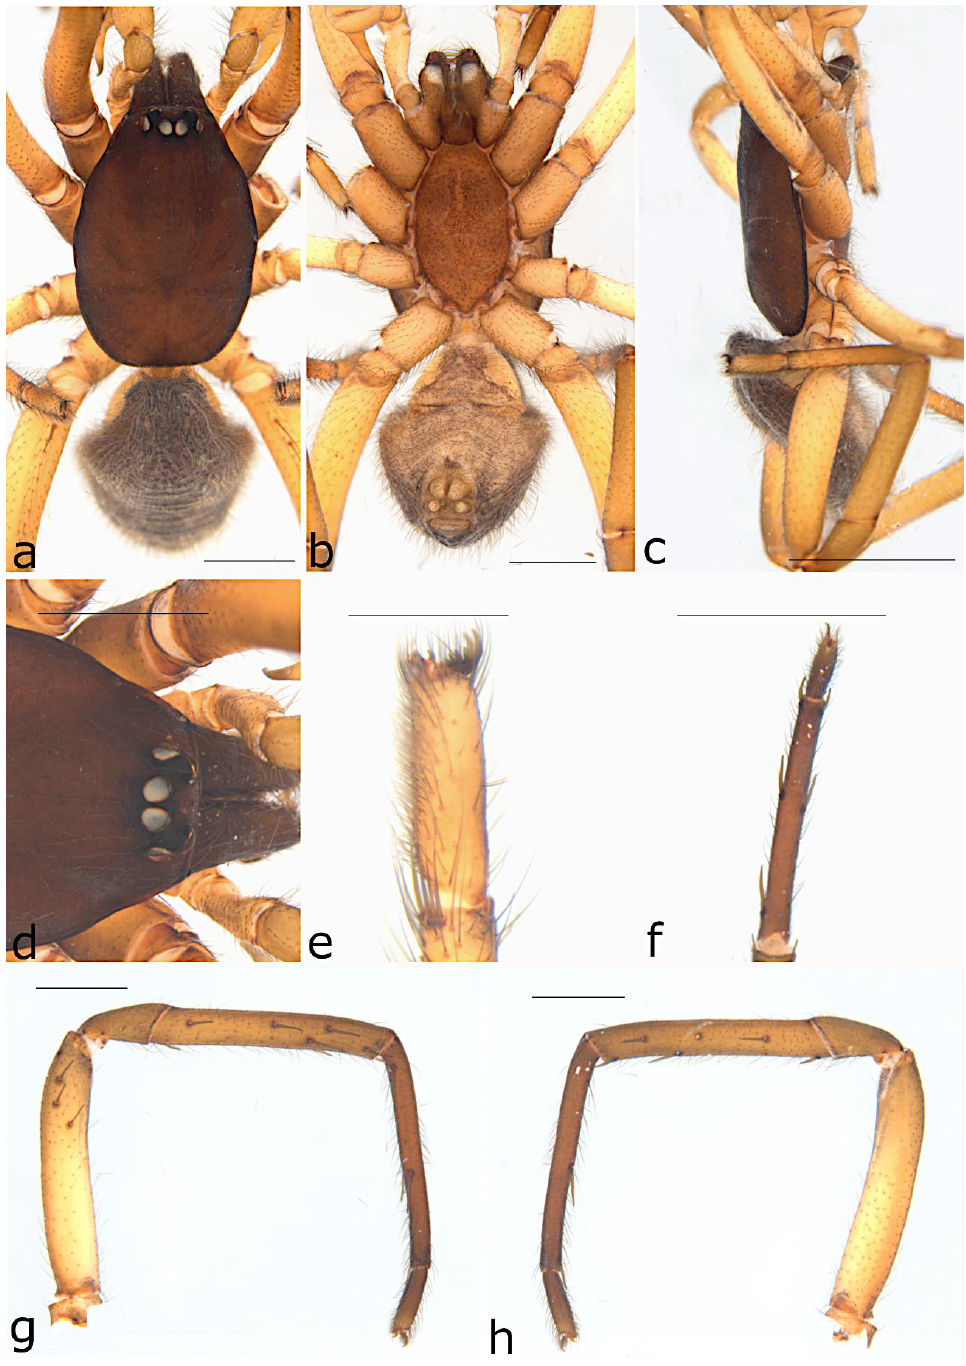
Figure 22. Ariadna umbra sp. nov. ♂ holotype (SAMA NN30621) from Naracoorte (SA): ( a ) habitus, dorsal view; ( b ) same, ventral view; ( c ) same, lateral view; ( d ) eyes, dorsal view; ( e ) left metatarsus IV, preening comb, retrolateral view; ( f ) left leg I, ventral view; ( g ) same, prolateral view; ( h ) same, retrolateral view. Scale bars ( a – d ) = 1 mm, ( e ) = 0.5 mm, ( f ) = 2 mm and ( g , h ) = 1 mm.